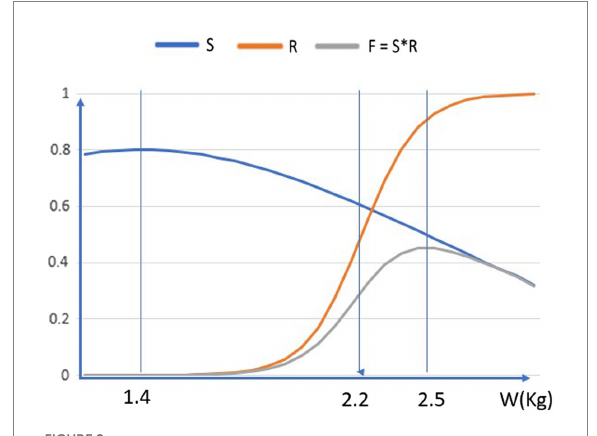
FIGURE 2 Illustration of sexual selection for size of the human brain. The optimum point for an individual is where the probability of surviving to adulthood and finding a mate (S*R) is maximized. The optimum point moves to the right over evolutionary time, increasing the handicap in survival fitness from sexual